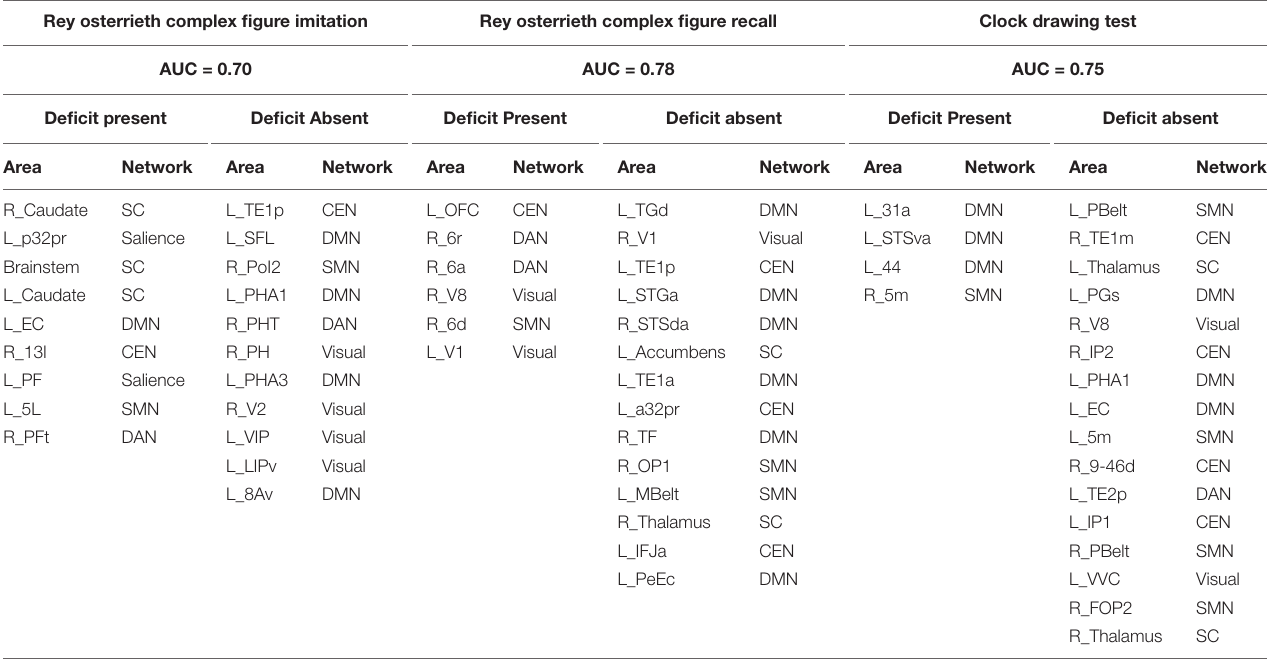
TABLE 4 | Predictors of performance in neuropsychiatric tests associated with visuospatial function. Rey osterrieth complex figure imitation Rey osterrieth complex figure recall Clock drawing